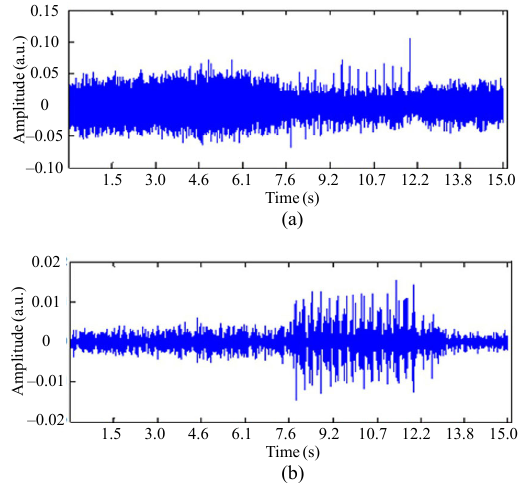
Fig. 35 Denoising process: (a) the original signal buried in the background and (b) the denoised signal with wavelet packet decomposition.